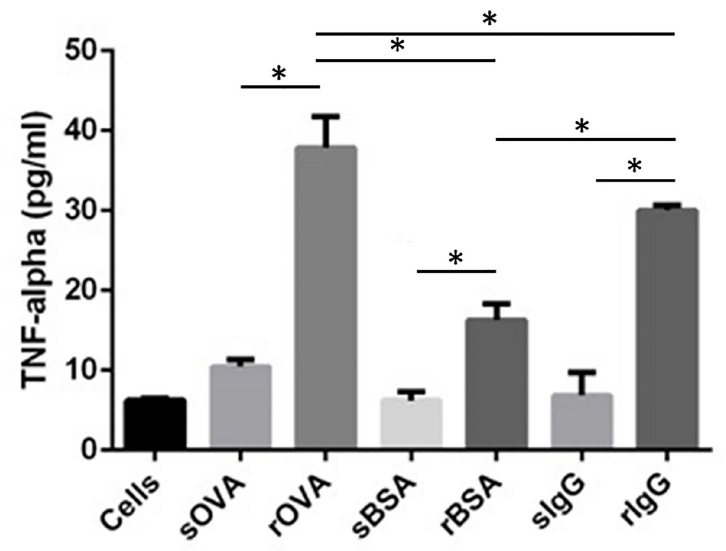
Fig 2. TNF- α production in J774 macrophages in response to ligand presentation on sphere (s) and rod shaped (r) particles. TNF- α values are averages +/- standard deviation of n = 3 and � denotes p < 0.05 as determined by one-way ANOVA followed by Tukey’s multiple comparison